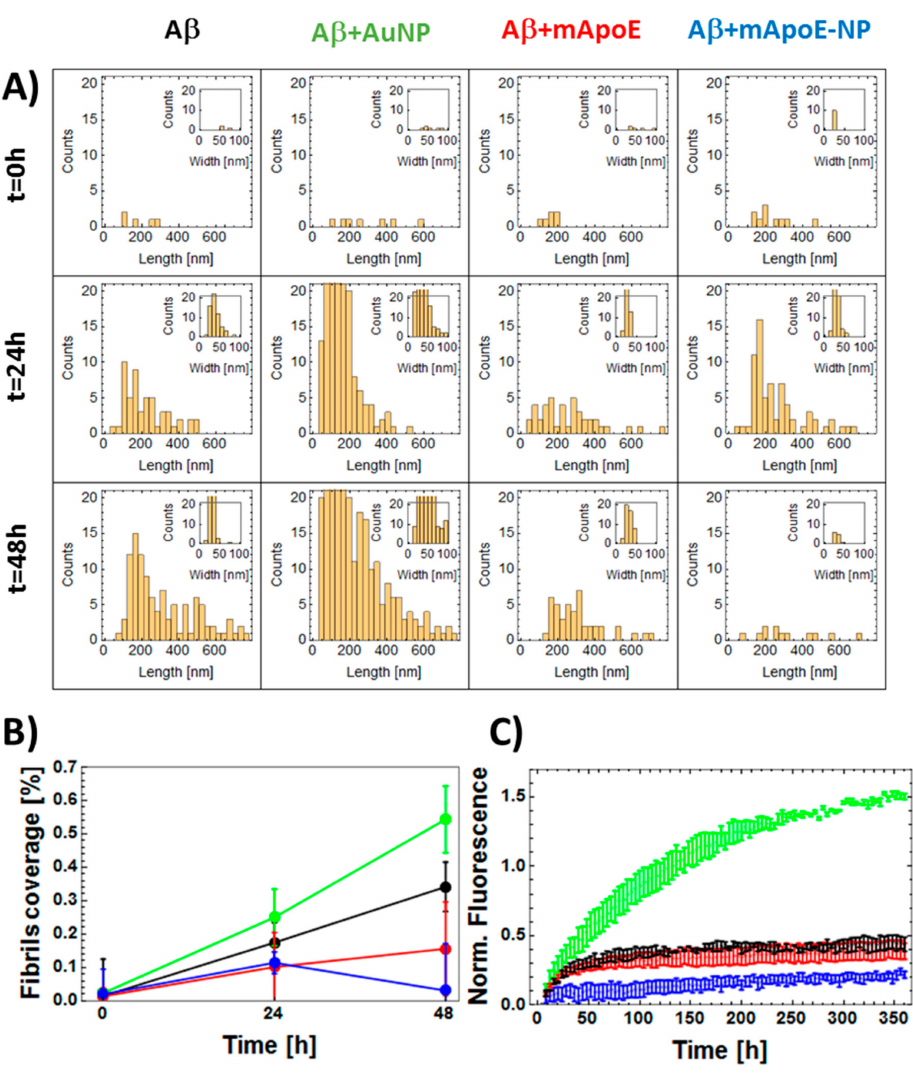
Figure 4. Quantitative analysis of the e ff ect of external chemical agents on the aggregation of A β 1-42. ( A ) Statistical distribution of fibrils length (main figures) and width (insets) as obtained from the analysis of AFM data reported in Figure 3B. Similar to Figure 3, data obtained using treatments indicated by the top labels (bare A β 1-42, A β in the presence of bare AuNP, free mApoE, or AuNP coated with mApoE) and left labels reporting the di ff erent incubation times ( t = 0 h, t = 24 h, t = 48 h). ( B ) Quantitative analysis of AFM images reported in panel A. Percentage of deposited fibrils covering the surface plotted as a function of time of aggregation. Data obtained for A β 1-42 bare in solution (black dots) or in the presence of free AuNPs (green dots), free mApoE (red dots), or AuNP coated with mApoE (blue dots). ( C ) FITC fluorescence representing the aggregation of 30 nM FITC-A β 1-42 as a function of the aggregation time: free A β (black dots) is compared to A β added with bare AuNP (green dots), free mApoE (red dots), or AuNPs coated with mApoE (blue dots). The normalized fluorescence values are obtained as (F(t) − F(0)) / F(0), where F(t) and F(0) are the fluorescence values measured at time t and 0. The normalized fluorescence values are the average of three repetitions. Error bars represent standard